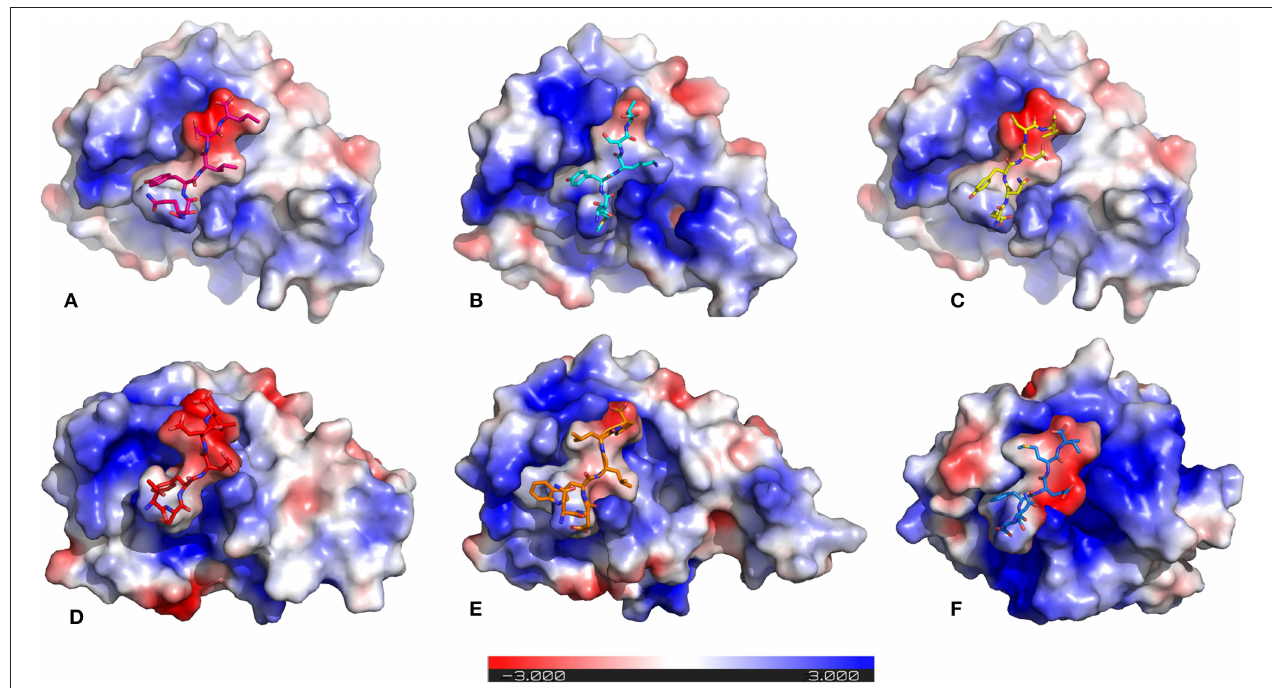
FIGURE 4 | Electrostatic surface potentials mapped on the six AIM/LIR— Pf Atg8/ Hs LC3 complexes reveal their charge complementarity. The binding position of peptides – (A) Pf Sec62 QSYIDI (magenta), (B) Pf Sec62 SMYKSI (cyan), (C) Pf Sec62 ENYDCL (yellow), (D) Pf Sec62 TSFEEL (red), and (E) Pf Atg3 NDWLLP (orange) in Pf Atg8 and (F) Hs Sec62 NDFEMI (blue) in Hs LC3 are also represented in sticks for better understanding. Blue surface on the protein represents positive charge and red represents negative charge and white